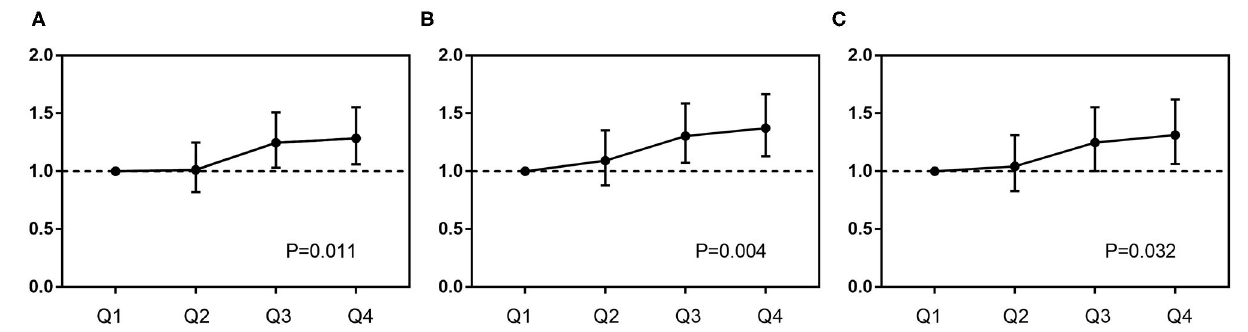
FIGURE 3 | Predictive value of DB for mortality in different Cox proportional models. Covariates in Model 1 (A) : age, sex, and body mass index; Model 2 (B) : SS II; Model 3 (C) : SS II, glucose metabolism status, treatment strategies, previous history of stroke, body mass index, blood pressure, low-density lipoprotein-cholesterol, high-sensitivity C-reactive protein, and liver